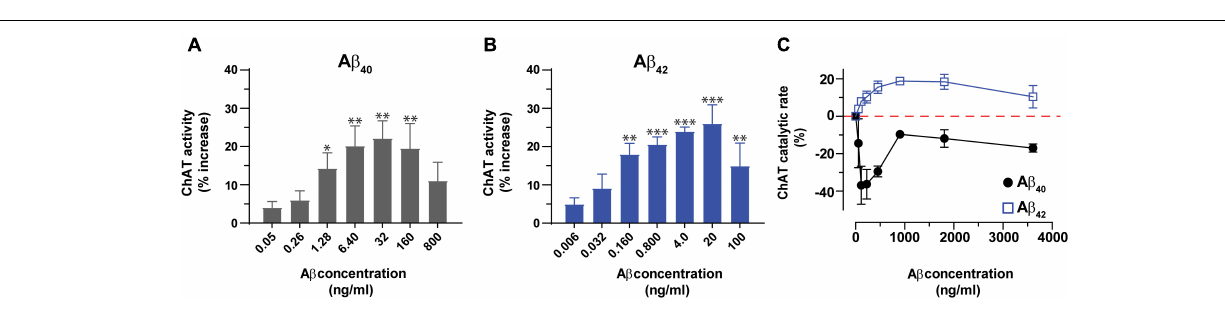
FIGURE 2 | A β peptides directly alter the activity of ChAT at both physiological and non-physiological concentrations. ChAT was incubated with A β peptides at physiological concentration ranges and changes in its activity were monitored using the kinetic ChAT fluorometric assay. (A) The percent changes in the rate of ChAT ( (cid:49) RFU/h) by A β 40 at the specified concentration range of 0–800 ng/mL. (B) The corresponding percent of changes in ChAT activity by A β 42, at the specified concentration range of 0–100 ng/mL. The activity of control sample (ChAT with no A β ) was considered as 100% to calculate the % increase in ChAT activity in the presence of different A β concentrations. The values are shown as mean ± SEM of ≥ 3 independent experiments. (C) The effect of high concentrations (non-physiological range) of A β peptides on ChAT activity was also monitored. ChAT was incubated with different concentrations of A β 40 and A β 42 peptides, ranging from 0 to 3,800 ng/mL in 96-well plates. The values are shown as mean ± SEM of two independent experiments. For A β 40 (A) , the symbols ∗ and ∗∗ represents p -values < 0.03 and < 0.005 relative to the control (no A β 40), respectively. For A β 42 (B) , the symbols ∗∗ and ∗∗∗ represents p -values < 0.005 and < 0.0003, respectively, relative to the control (no A β 42). The comparisons are based on one-way ANOVA analysis and Fisher’s LSD post hoc